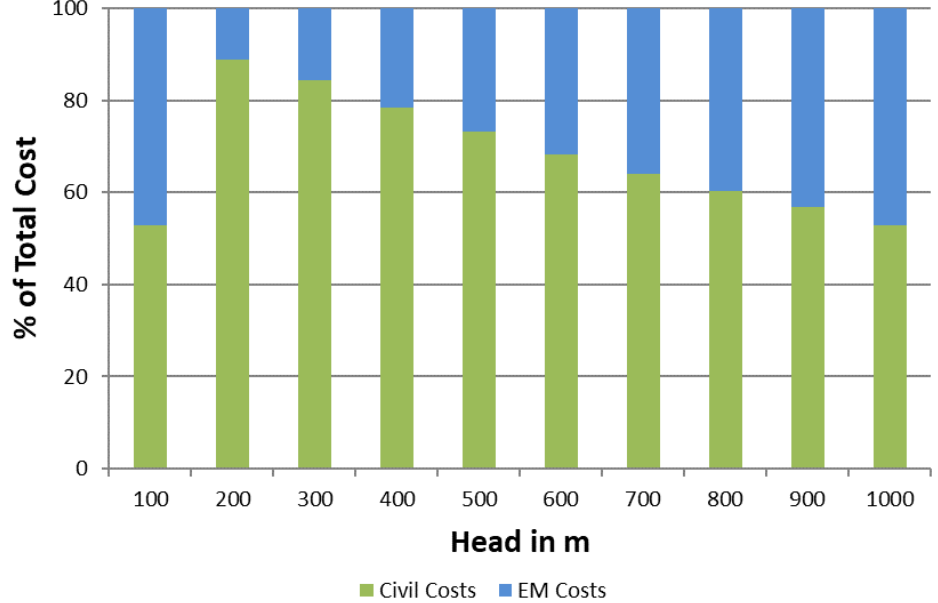
Figure 3. Cost of civil works vs. electro-mechanical components for 2000 kW plant. (ii)